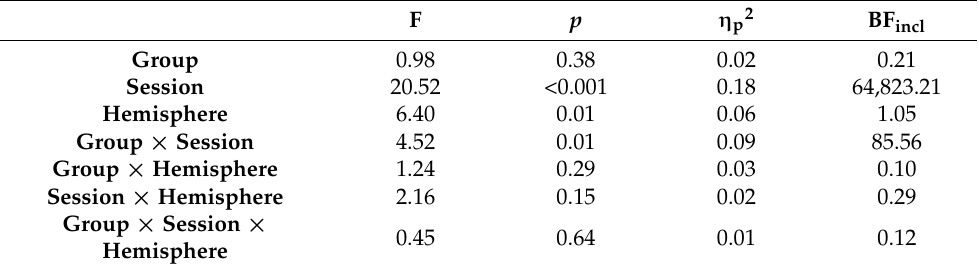
Table 2. Frequentist and Bayesian results from the ANOVA performed on the conflict effect estimated on response time.